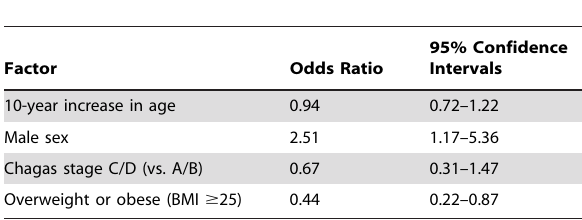
Table 5. Multivariable model of characteristics associated with positive results on conventional Trypanosoma cruzi PCR among seropositive